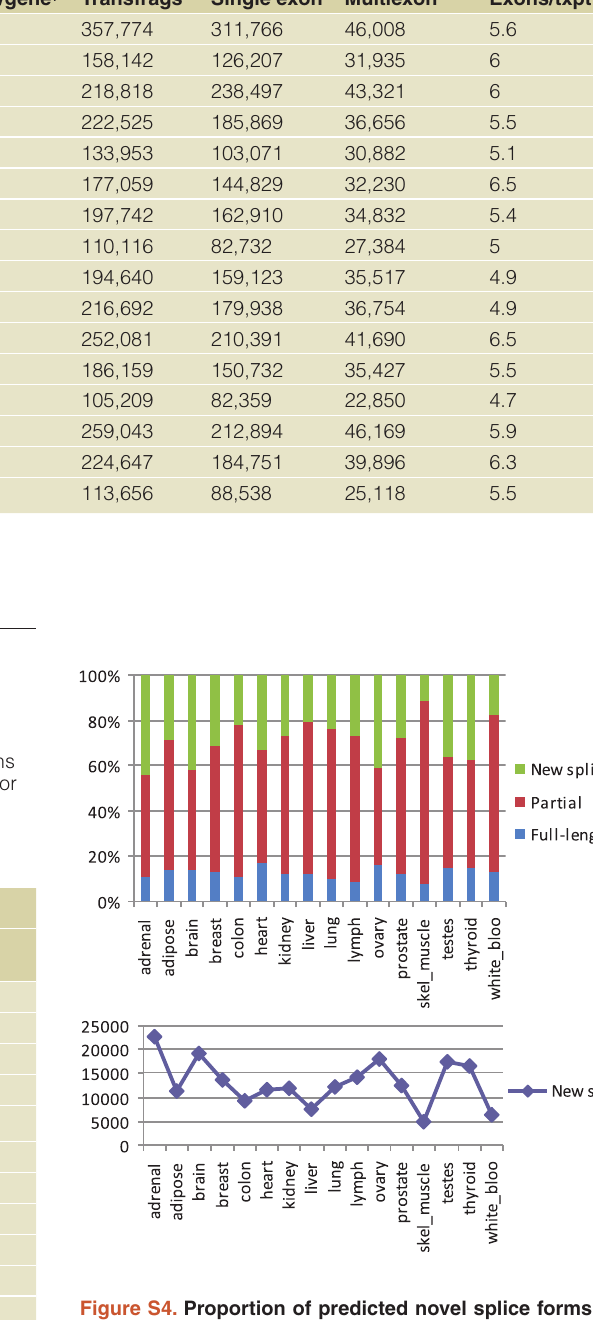
Figure S4. Proportion of predicted novel splice forms from the total number of transcript assemblies, including novel and known (top), and absolute counts of novel splice forms (bottom) detected in the 16 tissues. Novel and known isoforms are determined by comparison with ENSEMBL v.61 gene annotations using the program Cuffcompare (see caption to Table S4 for more